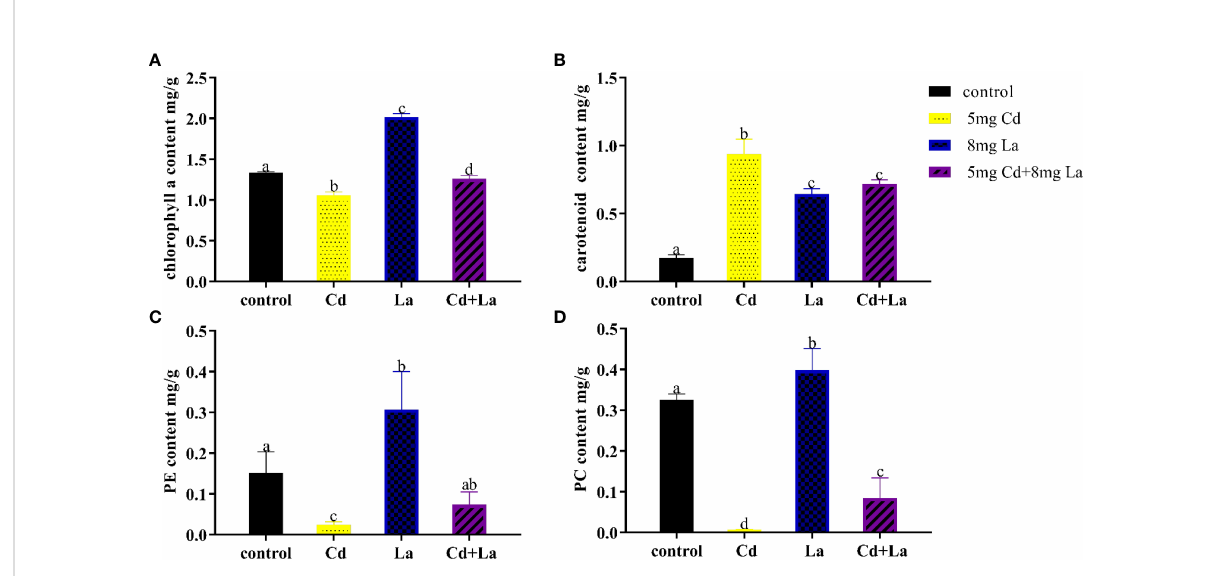
FIGURE 4 Pigment content of G bailiniae exposed to Cd, La, and their combination: (A) chl a, (B) carotenoid, (C) PE, (D) PC. Units: mg L − 1 . The data are presented as the mean ± standard deviation (n = 3). The lowercase letters indicate signi fi cant differences (ANOVA/Duncan ANOVA, P <